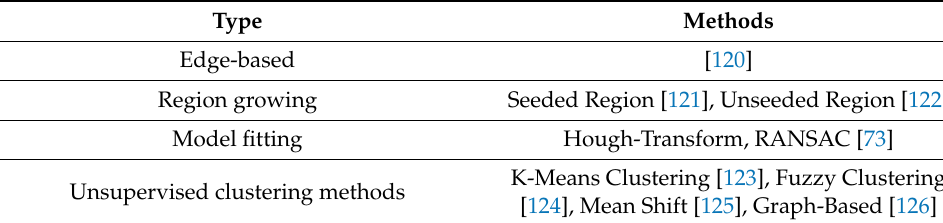
Table 6. 3D point-cloud segmentation methods.